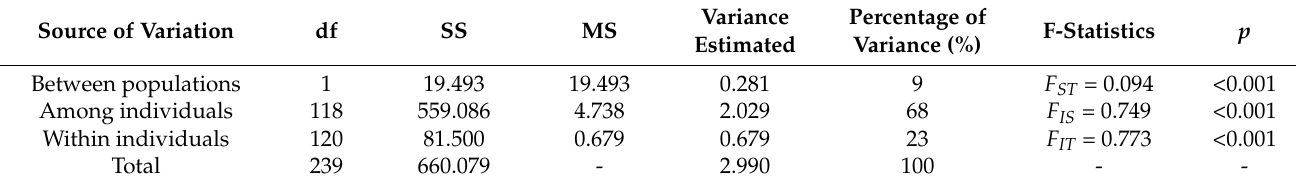
Table 4. Analysis of molecular variance (AMOVA) and F-statistics between DI and CI